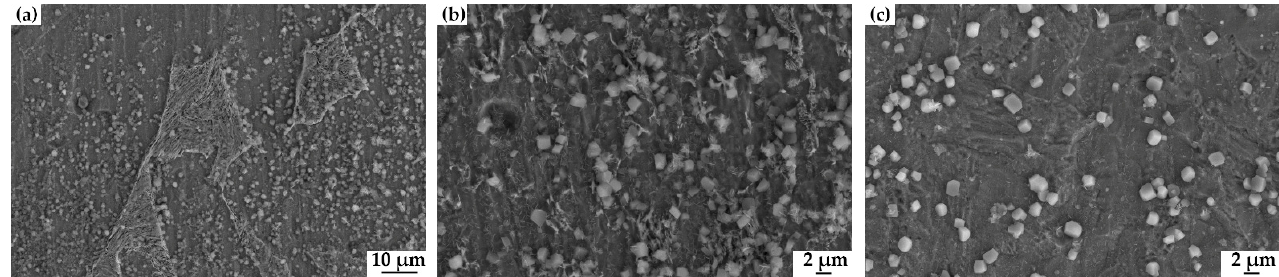
Figure 4. Polarization curve of 20#, X60, and X80 steels in NS4 solution.